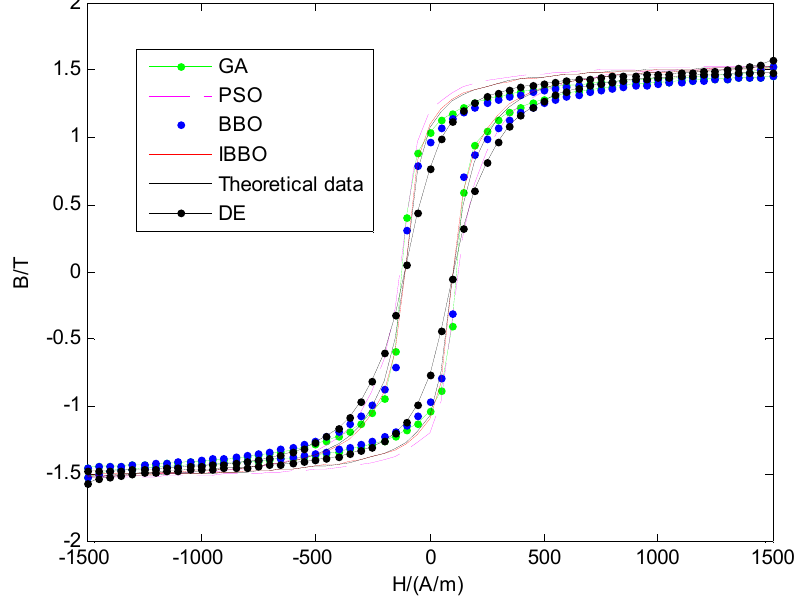
Figure 5. Hysteresis Loops for five different methods.